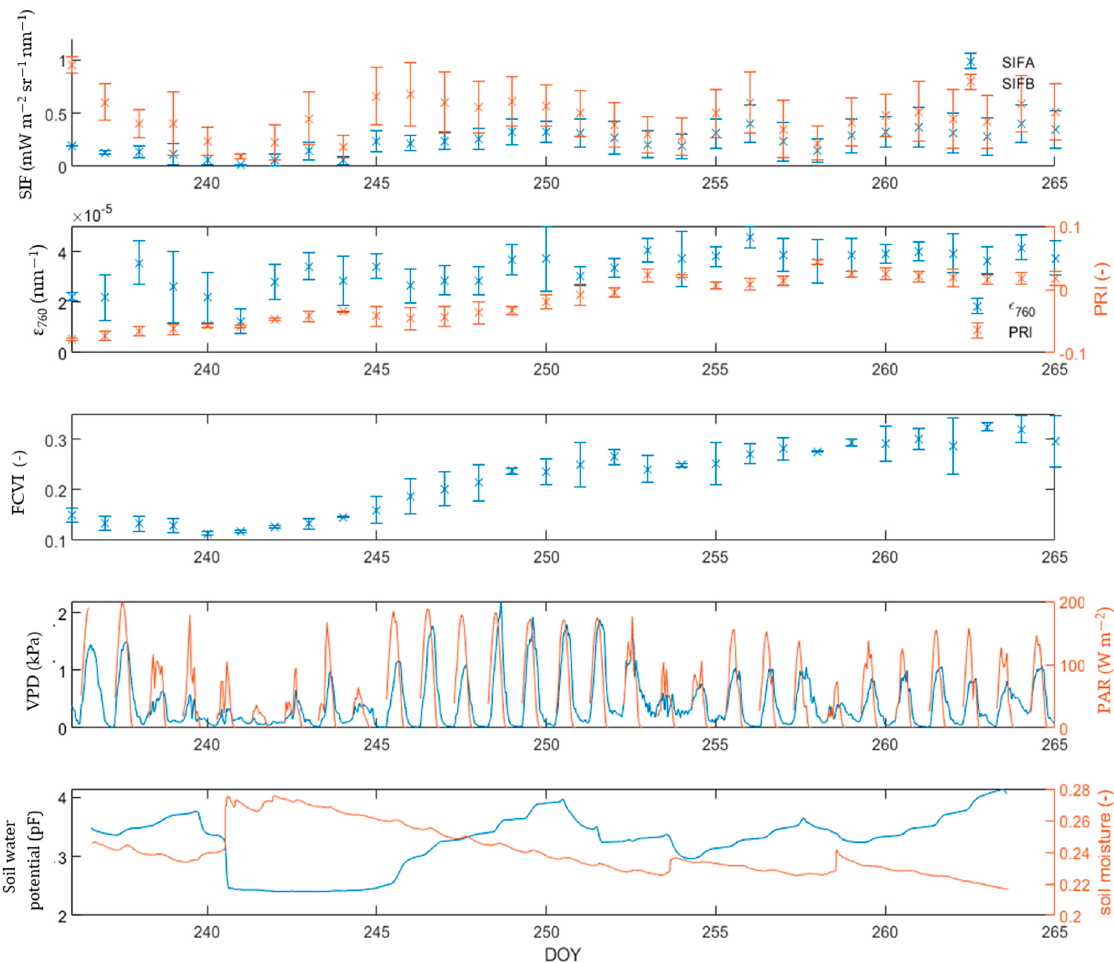
Figure 6. Evolution of SIFA, SIFB, ϵ 760 , FCVI, PRI for the lettuce campaign. The drought conditions are given by the VPD, PAR, soil water potential and soil moisture.